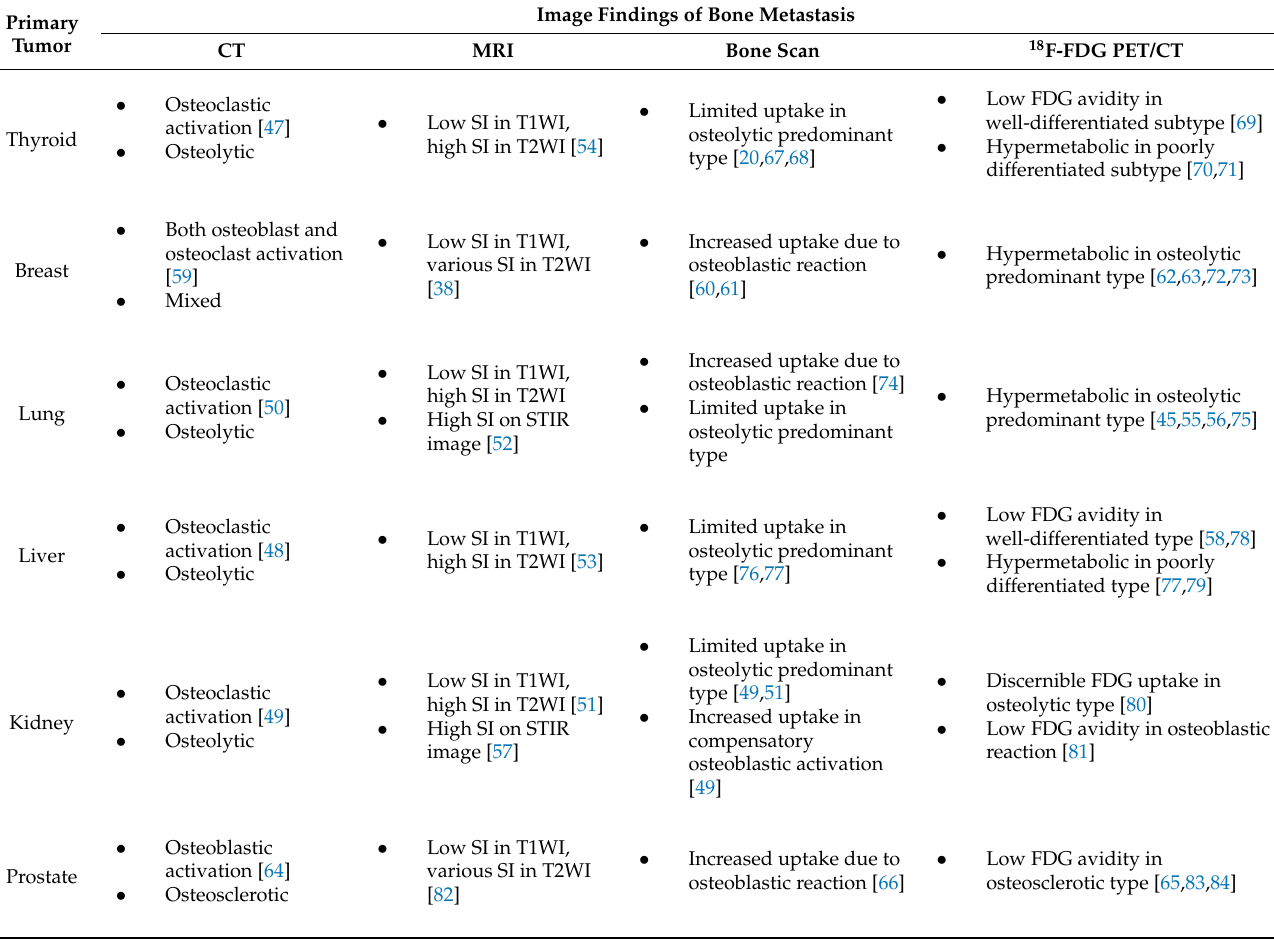
Table 1. Major imaging patterns of bone metastasis according to the primary